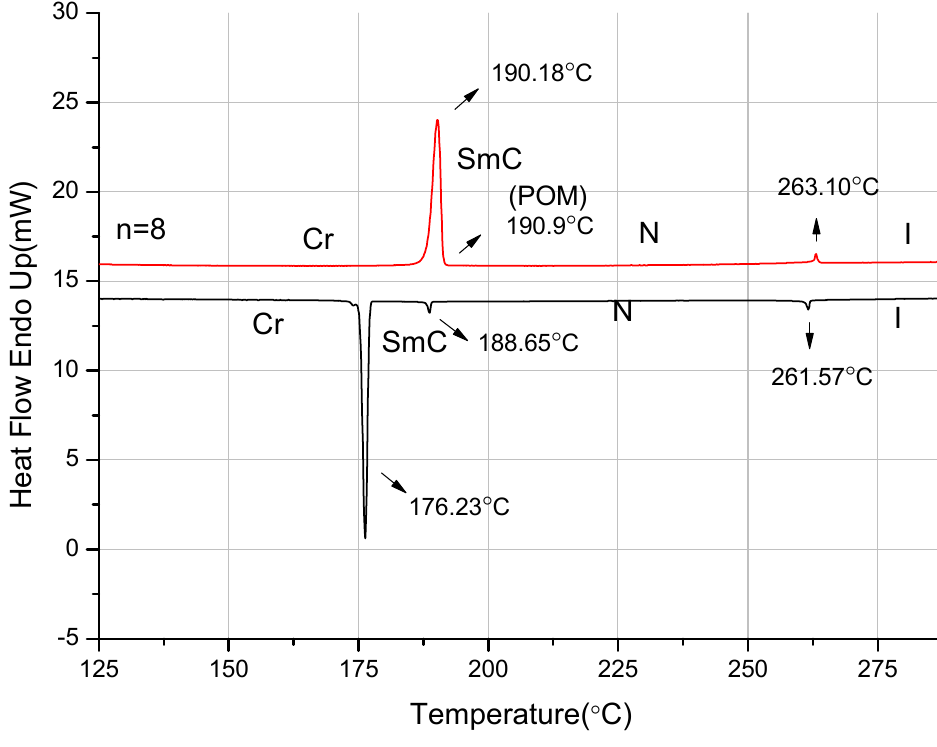
Figure 2. Polarized optical micrographs of 8O-PPQMe arise from isotropic phase on ( a ) heating to 260 °C; nematic Schlieren texture, ×200; and ( b ) cooling to 186 °C, smectic C texture,